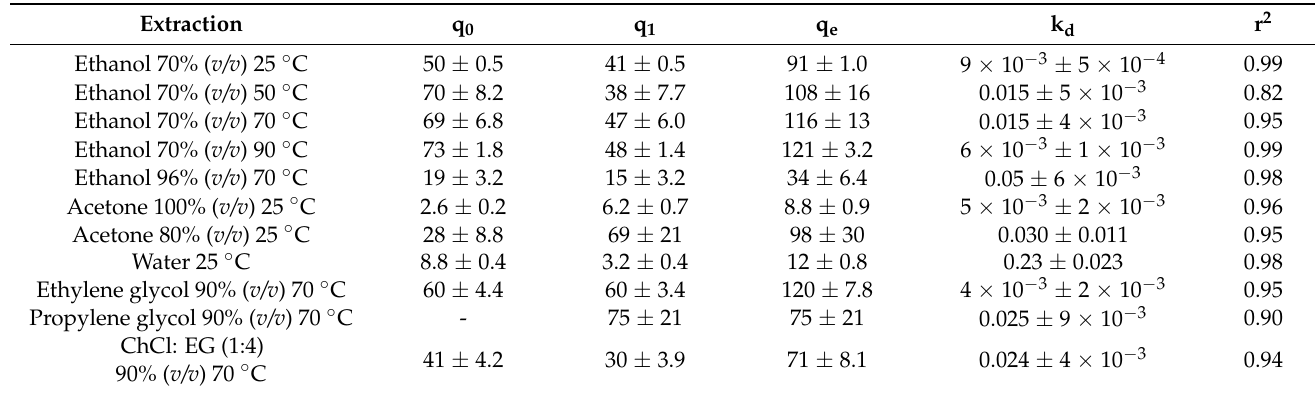
Table 4. Kinetic parameters from the extraction process of GP measuring antioxidant capacity by DPPH method; q 0 , q 1 , and q e are measured in TEAC/gds, while k d units are gds/(TEAC ·